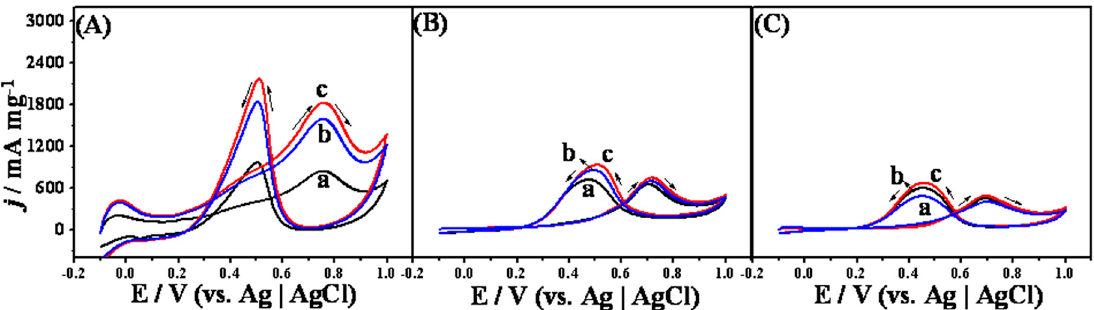
Figure 7. CVs of ( A ) Pt ‐ Ag/GNs, ( B ) Pt/GNs and ( C ) Pt/C ‐ JM in 0.5 M H 2 SO 4 + 1.0 M CH 3 OH; curves a, without irradiation; curves b, after visible irradiation for 30 min; curves c, after UV irradiation for 30 min.